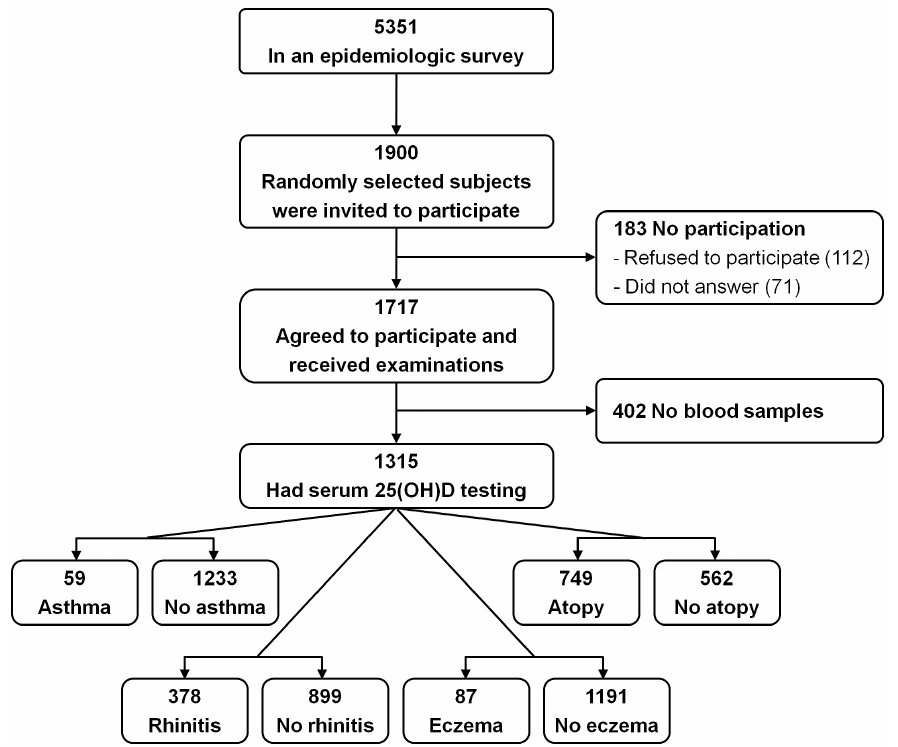
Figure 1. Schematic presentation of the recruitment process of the study subjects.